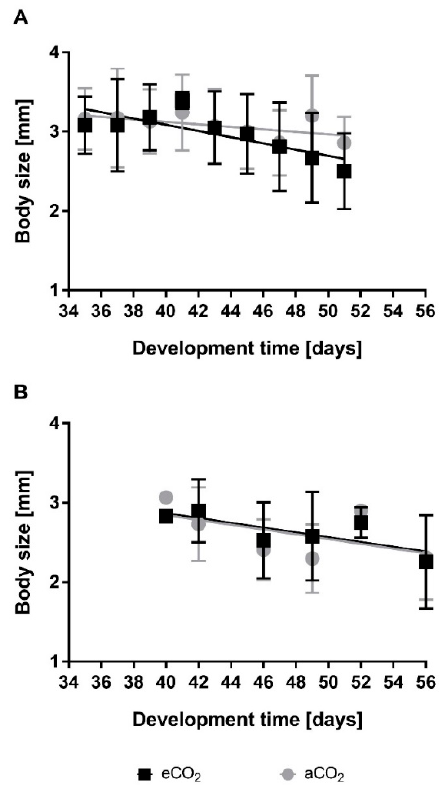
Figure 2. Pearson’s correlation analysis of female body size and sampling date of female P. ficus mealybugs at the onset of oviposition reared under elevated (eCO 2 , black squares) or ambient (aCO 2 grey circles) CO 2 conditions. Data displayed as means + SD. ( A ) Greenhouse data: eCO 2 R 2 = 0.63, p = 0.01; aCO 2 R 2 = 0.37, p = 0.08. ( B ) VineyardFACE data: eCO 2 R 2 = 0.60, p = 0.07; aCO 2 R 2 = 0.31, p = 0.25.